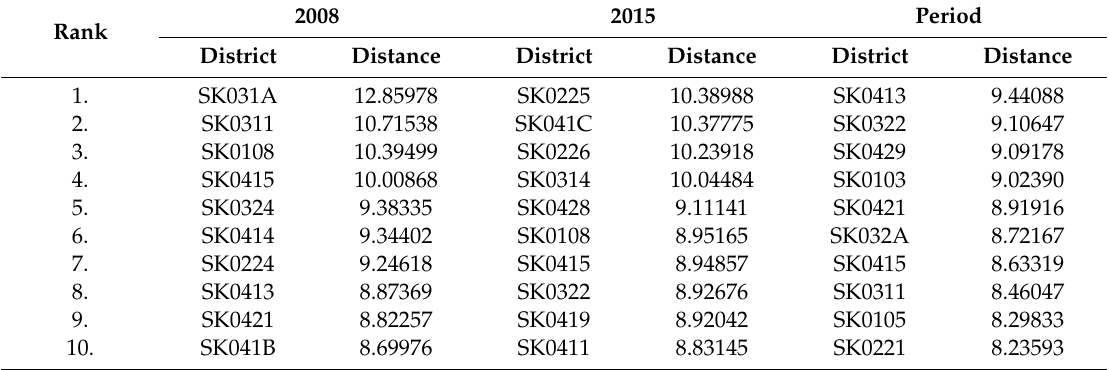
Table 4. The ten most extreme districts for the male sex preventable mortality.